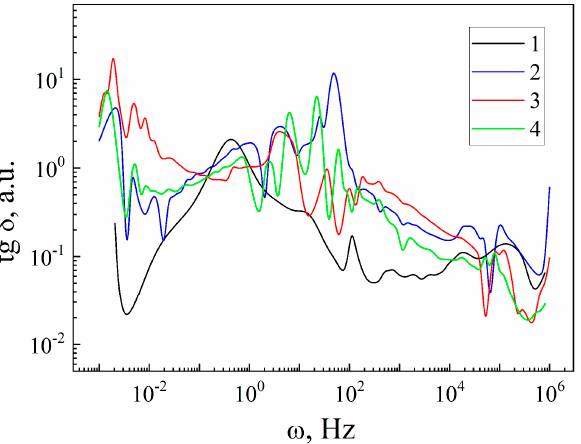
Figure 7. Frequency dependences of the tangent angles of dielectric losses of the matrix MSM-41 (1) and encapsulate MSM-41<SFA>, measured under normal conditions (2), in a magnetic field (3), and under illumination (4).